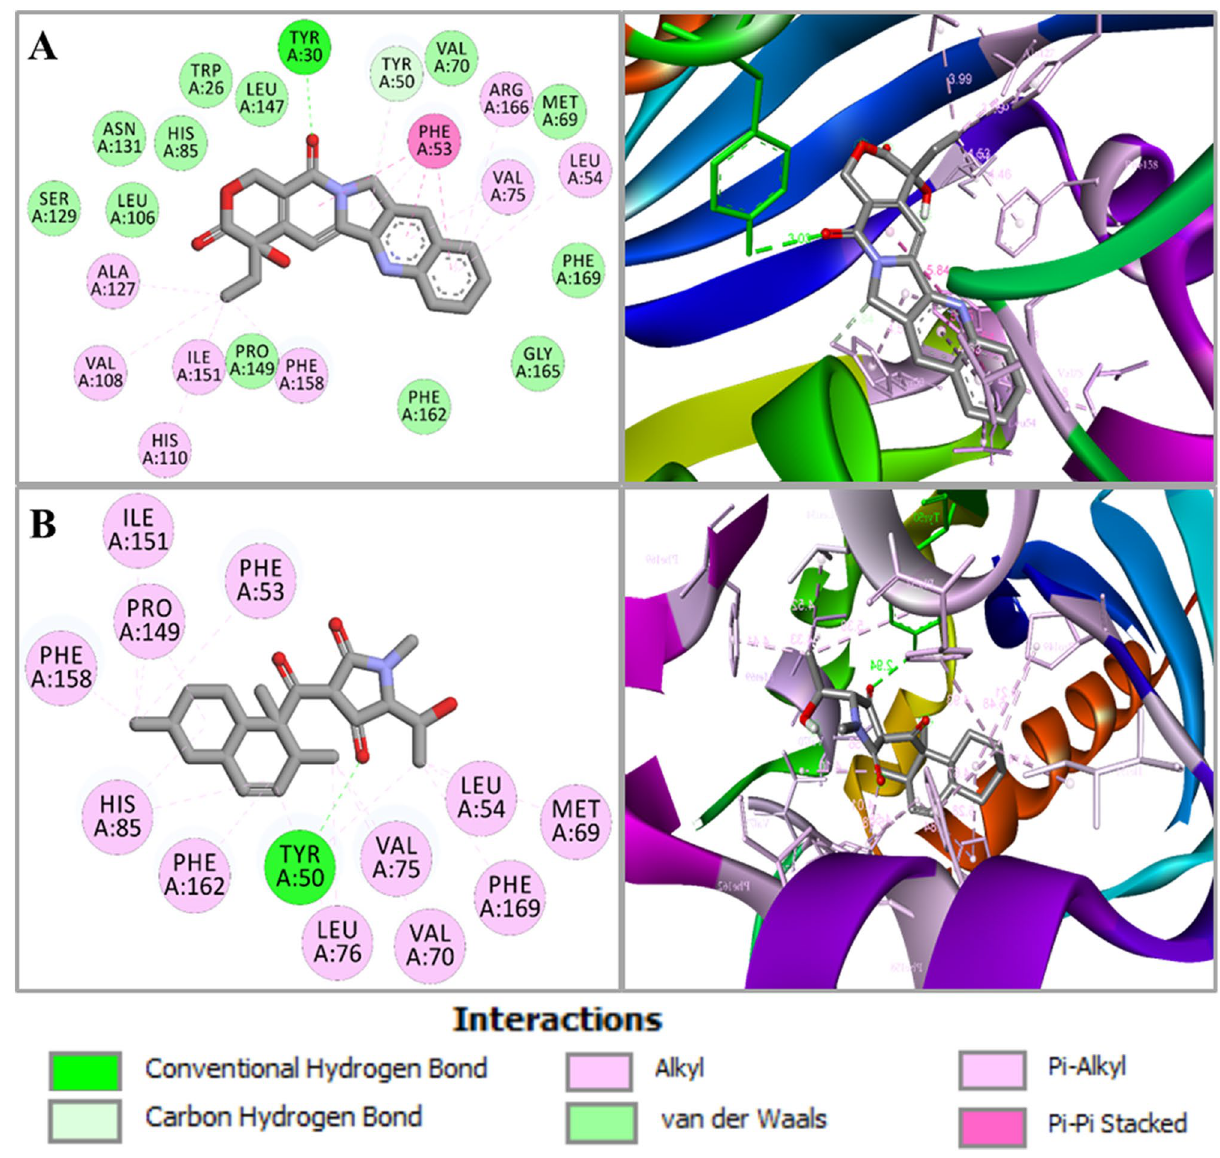
Figure 1. Molecular docking of the screened compounds. ( A ) Camptothecin docked in complex with scytalone dehydratase (PDB ID: 1STD); forming a hydrogen bond with side chain A:TYR30 and A:TYR50, whereas hydrophobic interactions with residues A:TYR50, A:PHE53, A:LEU54, A:VAL75, A:VAL108, A:HIS110, A:ALA127, A:ILE151, A:PHE158 and A:ARG166. ( B ) Interaction between compound cryptocin and scytalone dehydratase illustrated. A 2D interaction analysis is shown at left and 3D interaction analysis is shown at right